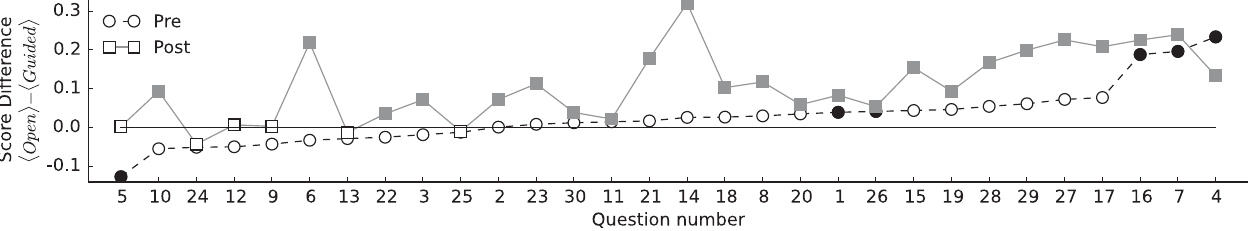
FIG. 2. Sorted plot of the difference between the average scores (points) of students in courses with open-ended activities and those with only traditional guided lab activities for each item of the E-CLASS. Zero difference is marked by the solid horizontal line. Filled markers indicate points for which the difference between the distributions of students in open-ended and guided lab only courses was statistically significant (Mann-Whitney U [21] and Holm-Bonferroni [27] corrected p < 0 . 05 ). See Ref. [28] for full list of item prompts.